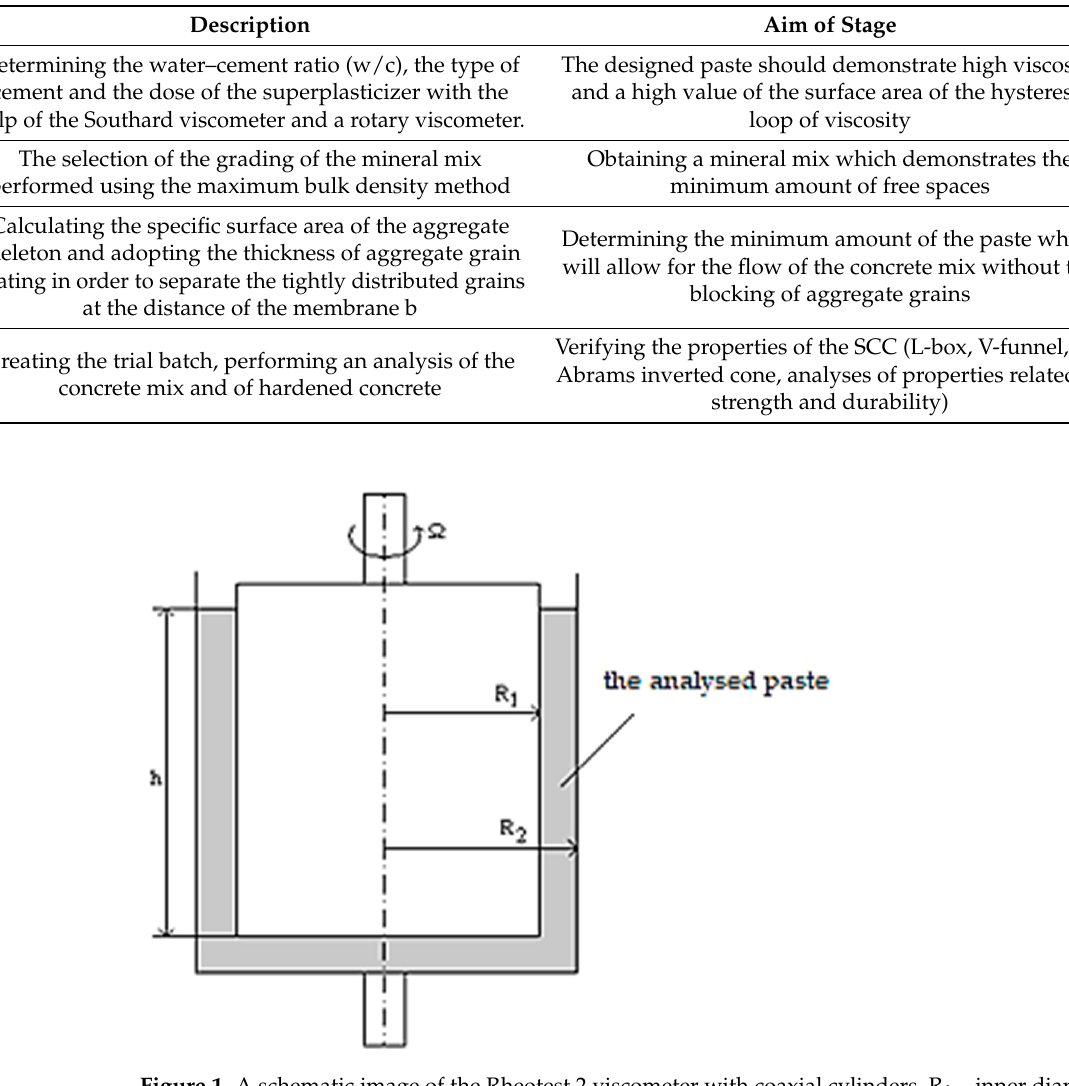
where: τ is the shear stress, dyn/cm 2 , Pa − 1 ; z is the cylinder constant, dyn/cm 2 ; and α is the value read from the indicating